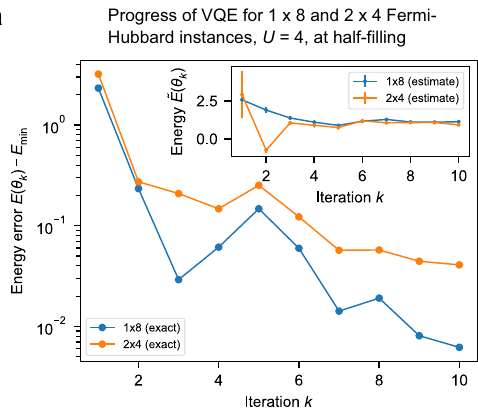
number. “ +Sym ” : also time-reversal symmetry. “ +TFLO ” : also Training with Fer- mionicLinearOptics 32 . “ +Coh ” :alsocoherenterrorcorrectioninTFLO. “ +PHS ” :also particle-holesymmetry.Raw/PSshownwithdifferentscaleforclarity.Reductionin errorusingalltechniquesise.g.~46×athalf- fi lling.Eacherrormitigationmethodis applied aswellasallprevious methods. Plots show a piecewise linearinterpolation between integer occupations. Error bars were calculated according to the proce- dure described in Methods section and are often too small to be visible.